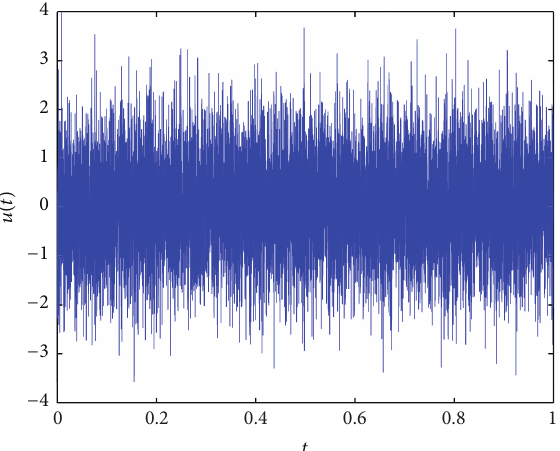
Figure 4: The displacement with a Wiener process, the numerical simulation of (63), where 𝛼 = 1.625 , 𝛽 = 0.723